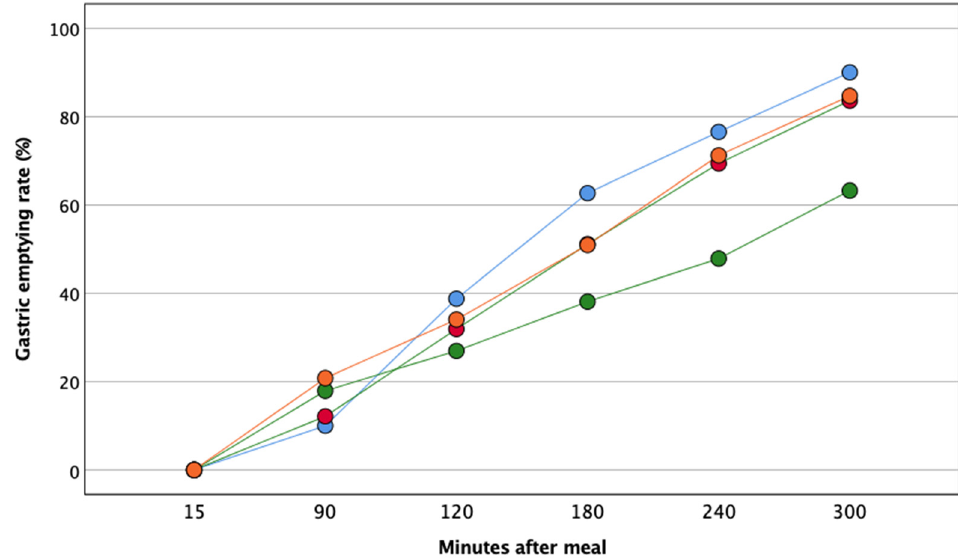
Figure 3. Gastric emptying rate evaluated by ultrasound in T1D and healthy controls after the two meals. Green and orange circles represent T1D after EVOO- and butter-enriched meals; blue and red circles represent controls after EVOO- and butter-enriched